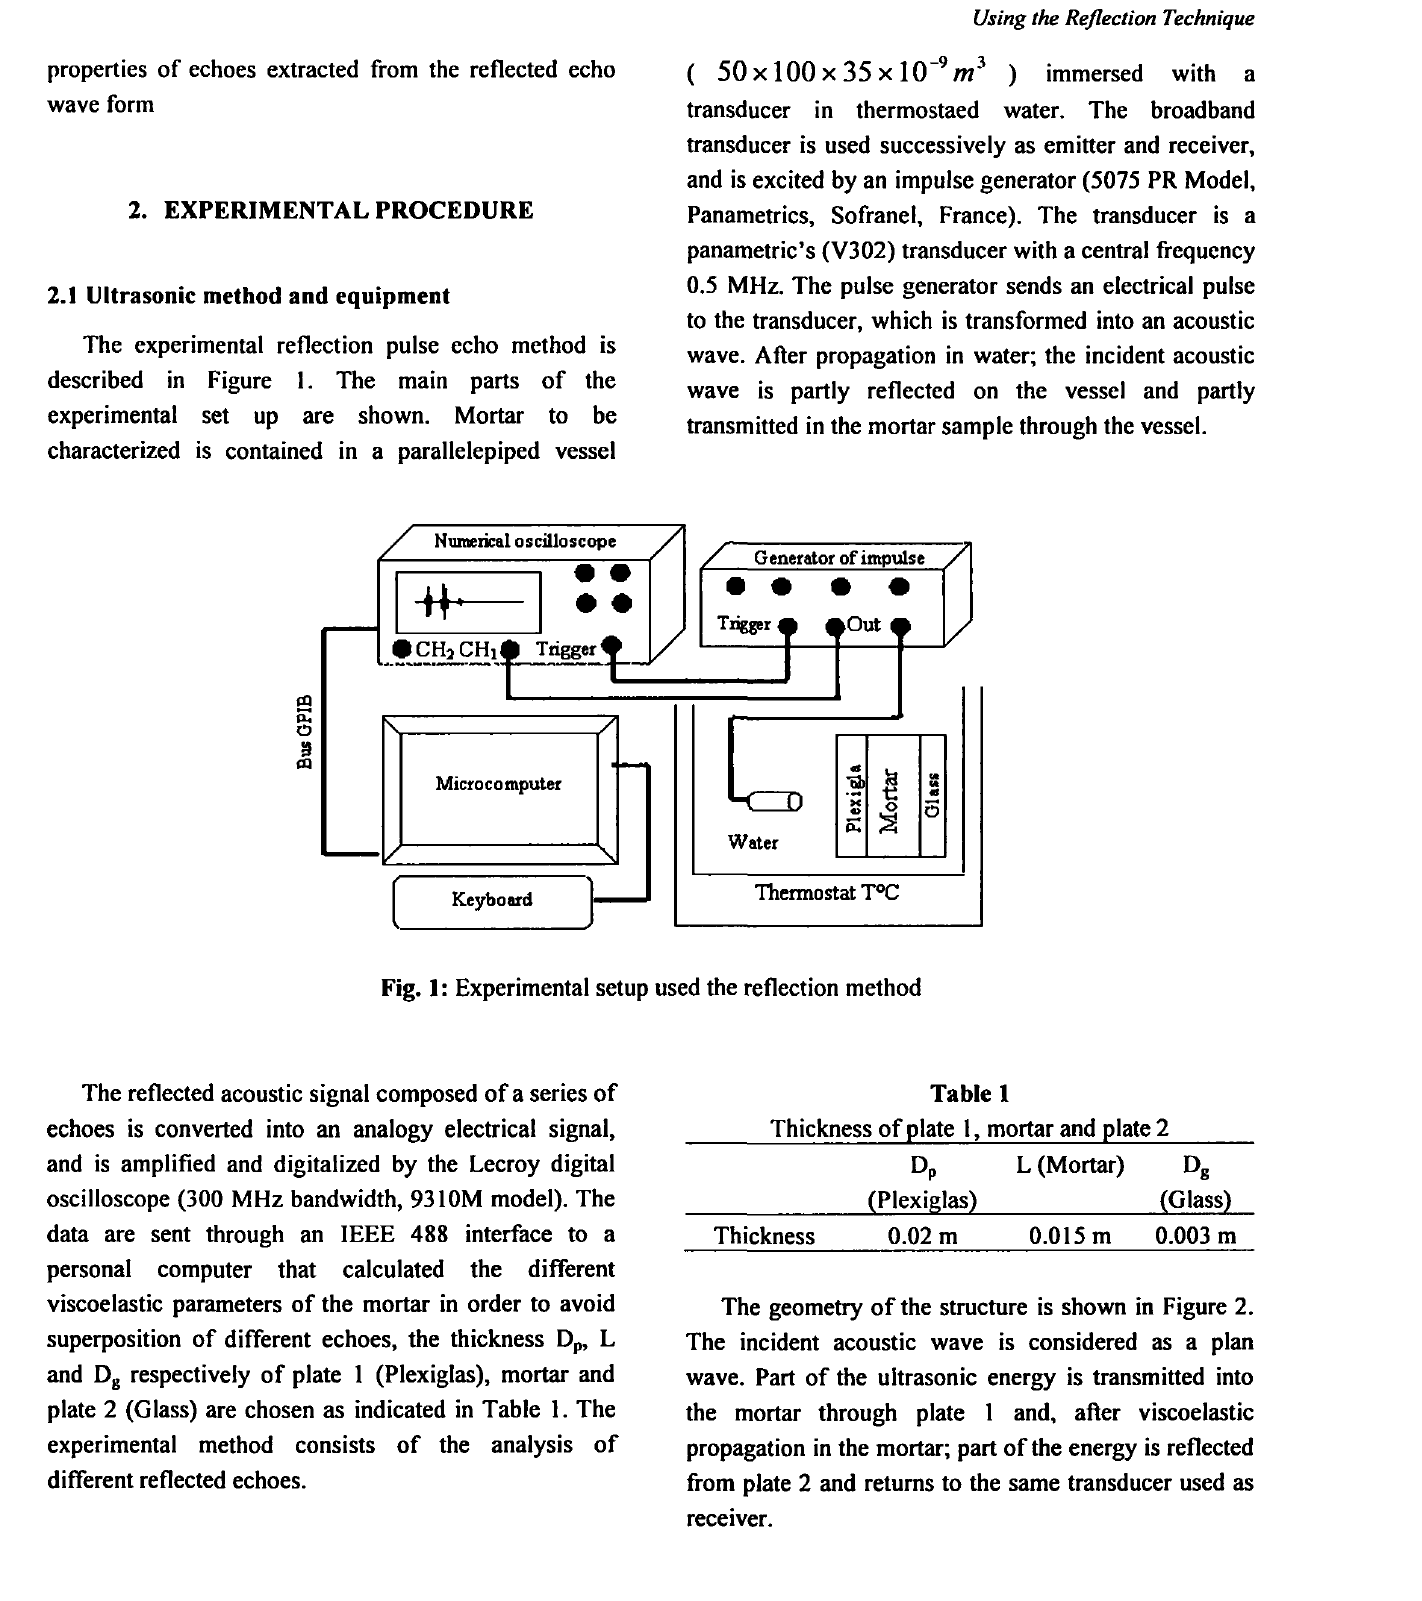
Fig. 1: Experimental setup used the reflection